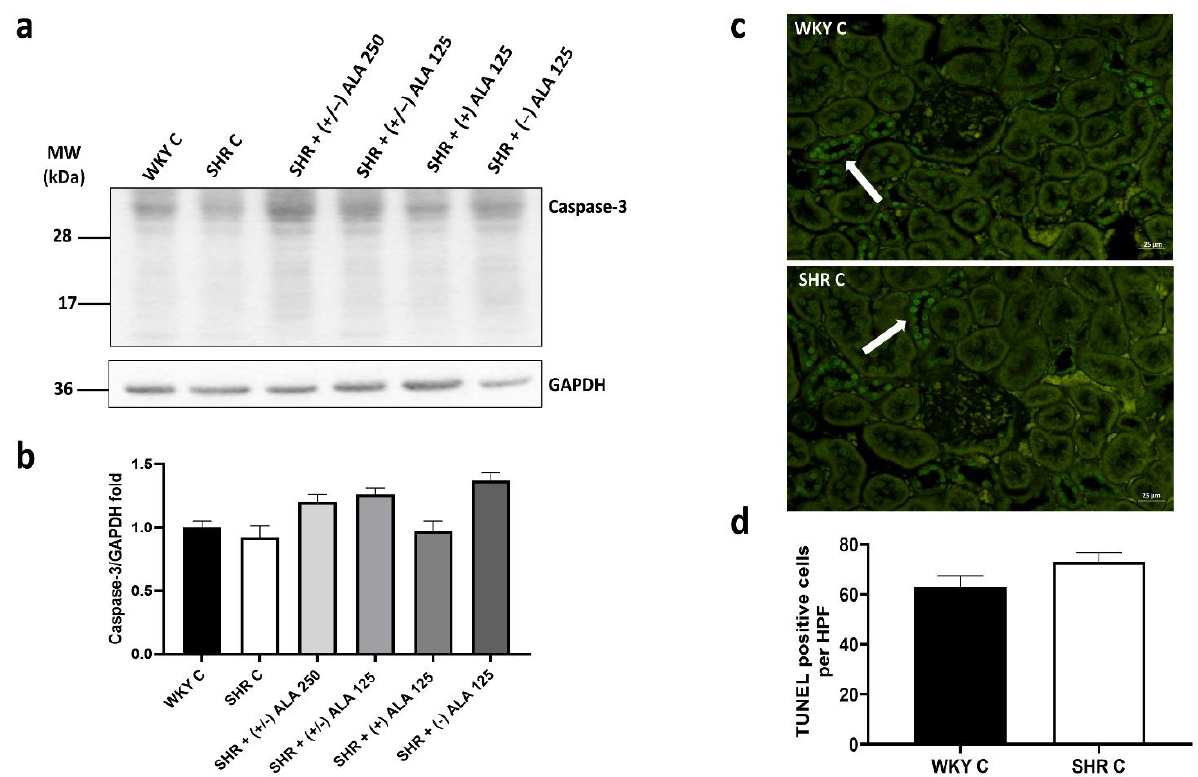
Figure 2. Apoptosis in the kidney. ( a ) Lysates of kidney from WKY C, SHR C, SHR + (+/ − ) alpha-lipoic acid (ALA) 250 µmol/kg/day, SHR + (+/ − ) ALA 125 µmol/kg/day, SHR + (+) ALA 125 µmol/kg/day, SHR + ( − ) ALA 125 µmol/kg/day were immunoblotted using specific anti caspase-3; ( b ) The bar graph indicates the ratio of densitometric analysis of bands and GAPDH levels, used as loading control, considering the WKY C group as reference. Blots are representative of one of three separate experiments; ( c ) Sections of kidney from WKY C and SHR C processed for TUNEL staining. Arrow: apoptotic nucleus. Calibration bar 25 µm; ( d ) Bar graph shows the quantification of the number of positive cells per high-power field (HPF) (40×). Data are mean ± S.E.M.